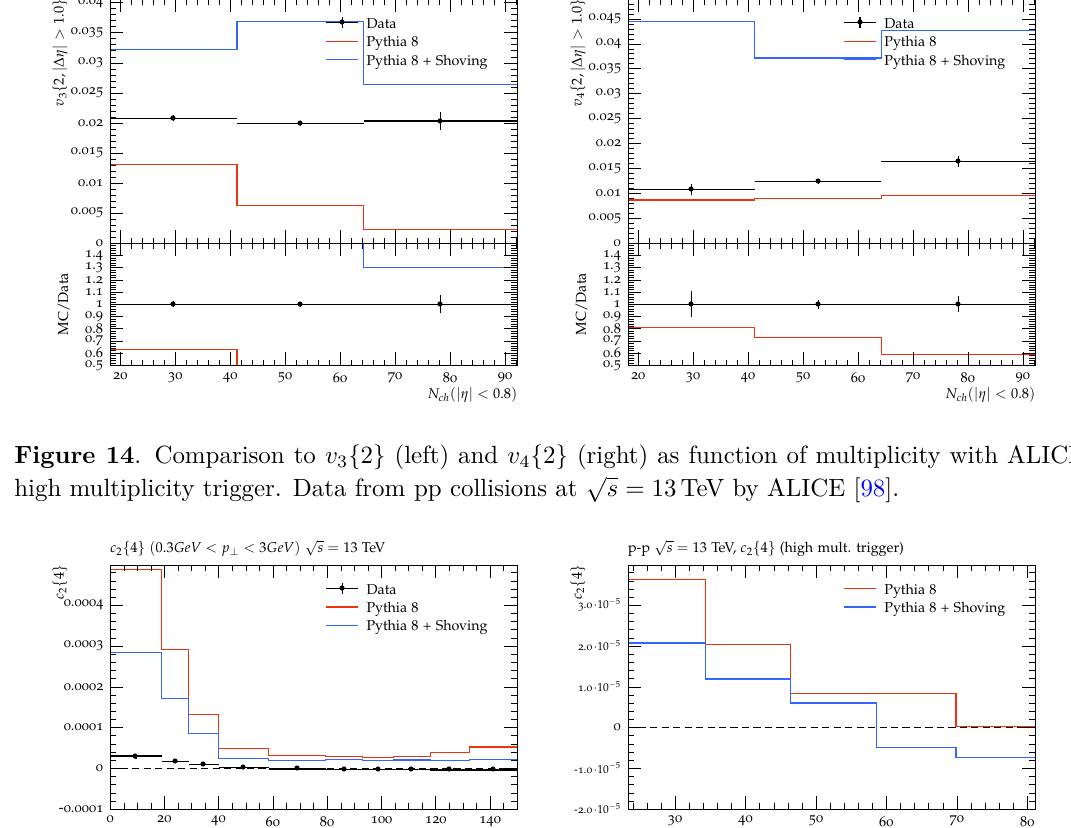
Figure 15 . The four-particle cumulant c 2 { 4 } , compared to data from CMS [99] (left), and with the ALICE high multiplicity trigger (no data,